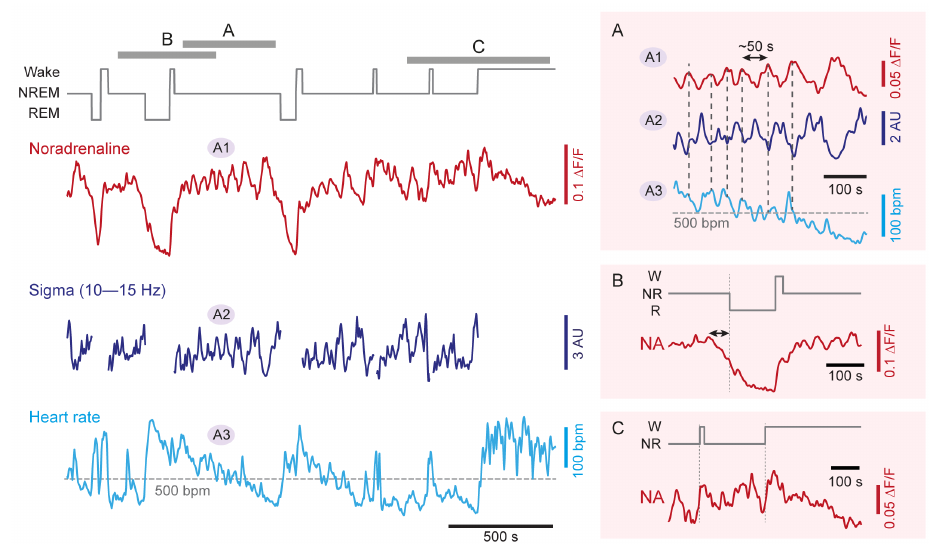
Figure 2. Real-time dynamics of NA levels in somatosensory thalamus, forebrain sleep spindle power, and heart rate during NREM sleep. Representative simultaneous recordings in a freely behaving mouse combining (from top to bottom): hypnogram ( gray ), free NA levels in somatosensory thalamus obtained through fiberphotometry imaging ( red , A1), local field potential sigma power (10–15 Hz) in somatosensory cortex ( dark blue , A2) and heart rate ( light blue , A3), with labeled portions (A, B, C) shown expanded on the right. The variations in sigma power reflect the clustering of sleep spindle density ([72]). Insets on the right expand portions of the traces highlighted with letters in the hypnogram to show ( A ) NREM sleep (double-headed arrow marks the 50 s periodicity); ( B ) NREM- to-REM sleep transitions (double-headed arrow marks the decay time of NA levels prior to REM sleep onset); ( C ) NREM-to-wake transitions. Portions of two of these traces have been published previously [72]. NA, noradrenaline; W, wakefulness; NR, NREM sleep; R, REM sleep; ∆ F/F, relative fluorescence changes; AU, arbitrary unit; bpm, beats per